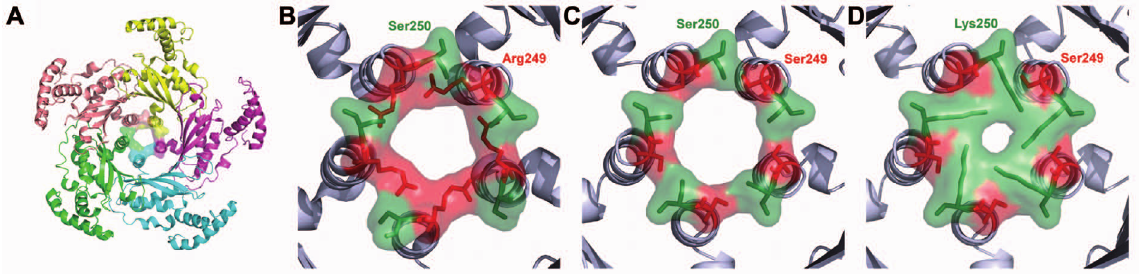
Figure 3 Compensated mutation in human GTP cyclohydrolase I. Residues 249 and 250 are shown with a surface in all five chains. (A) Structure of the wild-type homopentamer with each chain shown in a different color. (B) Zoomed view of residues 249 and 250 from all five chains with the residues shown in green and red, respectively. (C) The disease-causing Arg249 ™ Ser mutation modeled into all five chains. (D) The compensatory Ser250 ™ Lys mutation modeled into all five chains as well as the Arg249 ™ Ser